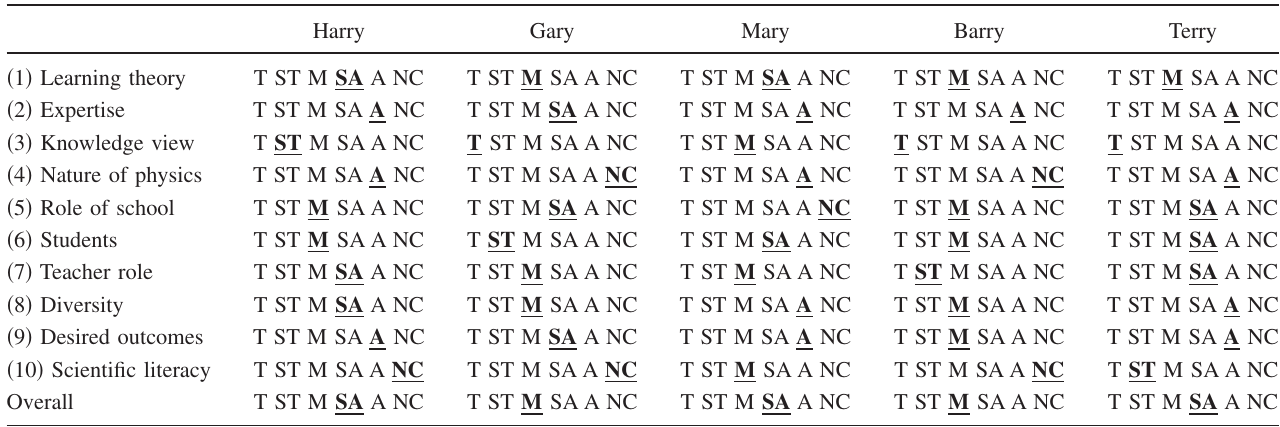
TABLE VII. Rating of interviewees’ instructional conceptions on main categories of conceptions. Harry Gary Mary Barry